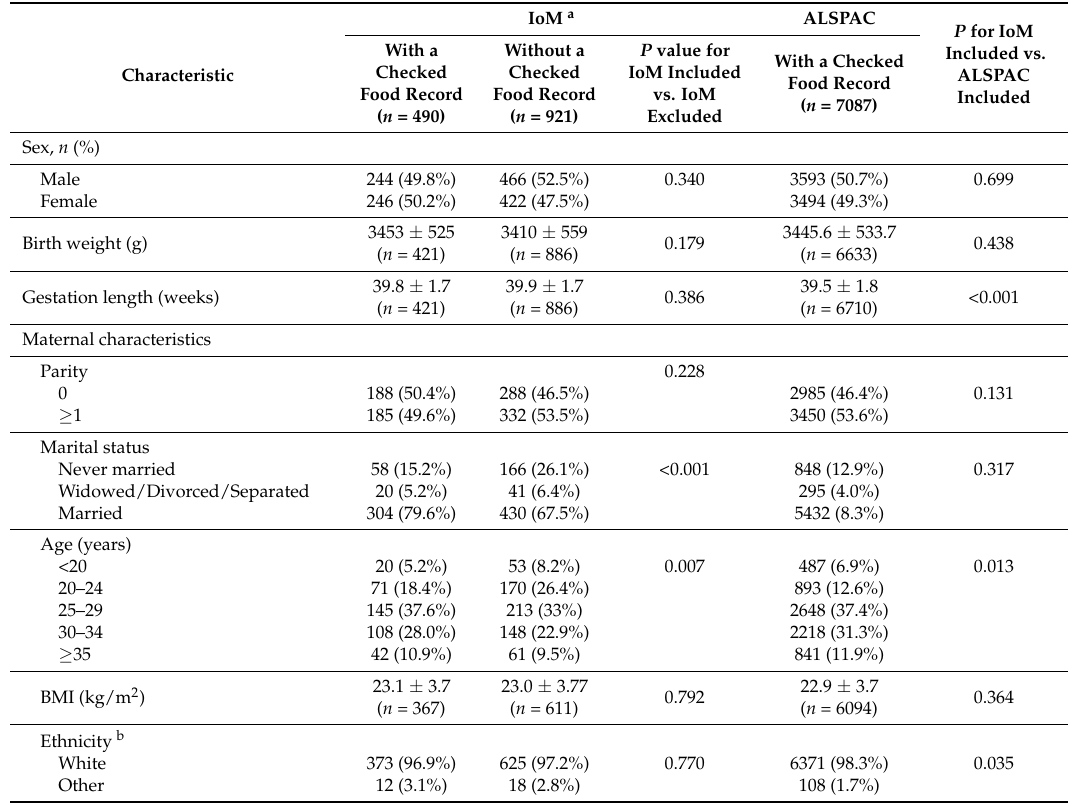
Table 1. Comparison of demographic characteristics between children in IoM with and without food records at 7 years of age, and children with food records in